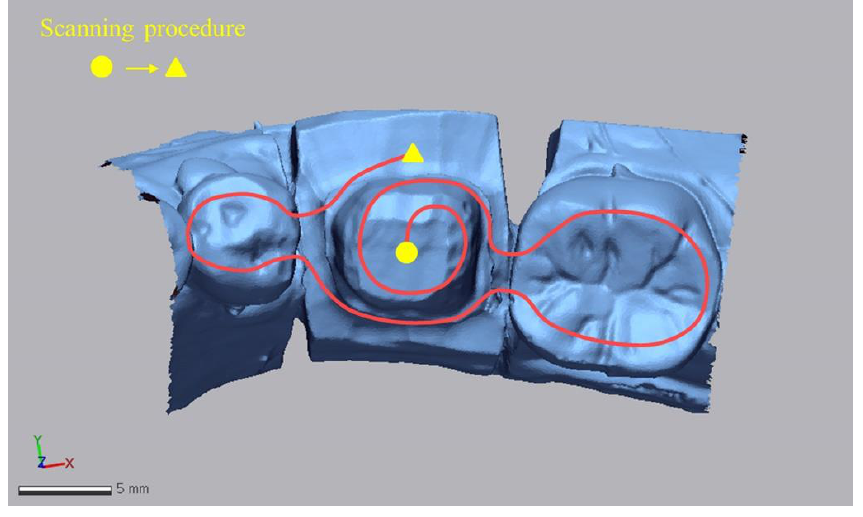
Figure 3. Scanning strategy for intraoral scanner.